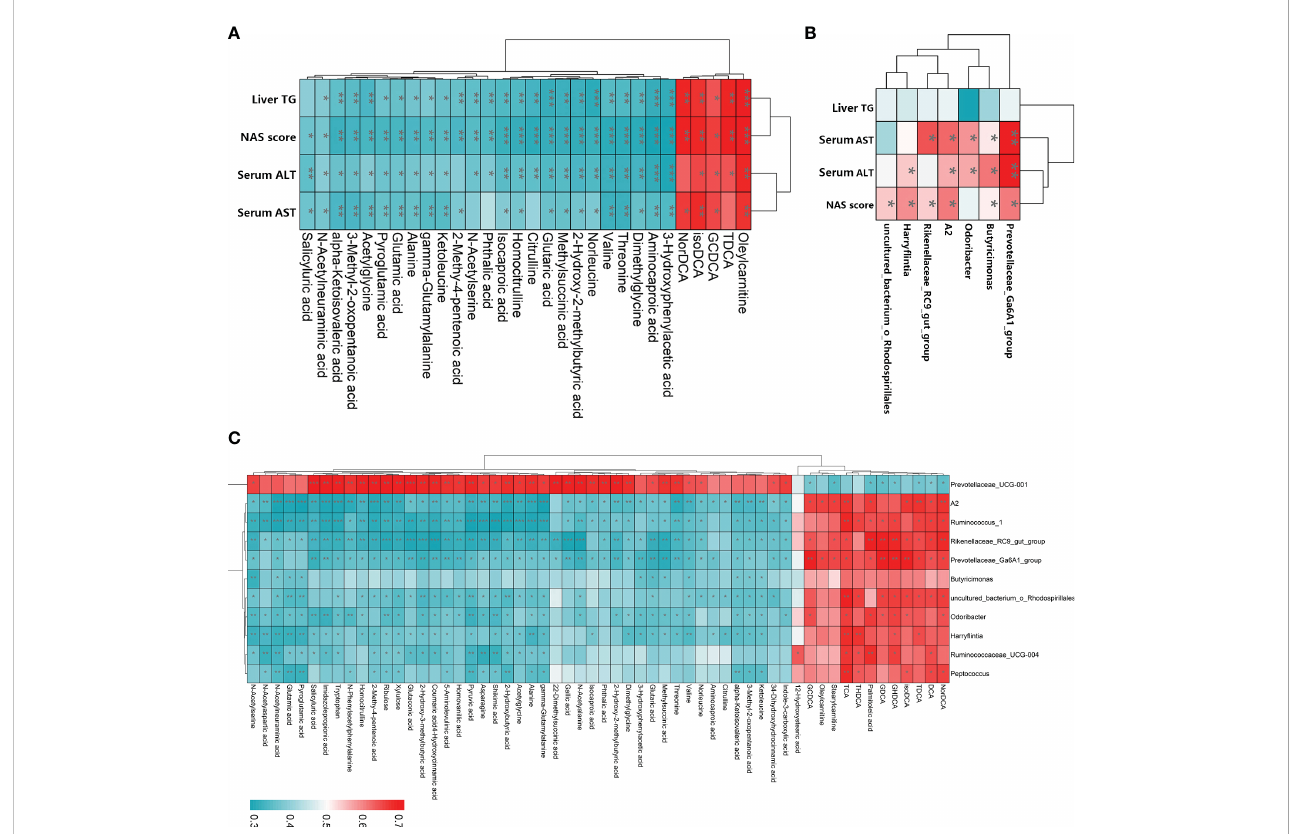
FIGURE 8 Spearman ’ s correlation analysis among LGZG reversed gut microbiota, fecal metabolites, and NASH indexes. (A) Correlation between LGZG reversed fecal metabolites and NASH indexes, the X-axis represented metabolites, and the Y-axis represented NASH indexes, (B) Correlation between LGZG reversed gut microbiota and NASH indexes, the X-axis represented gut microbiota, and the Y-axis represented NASH indexes, (C) Correlation between LGZG reversed metabolites and gut microbiota, the X-axis represented metabolites, and the Y-axis represented gut microbiota, the red color showed the positive correlation, and the green color showed the negative correlation, *p < 0.05, **p < 0.01, ***p <